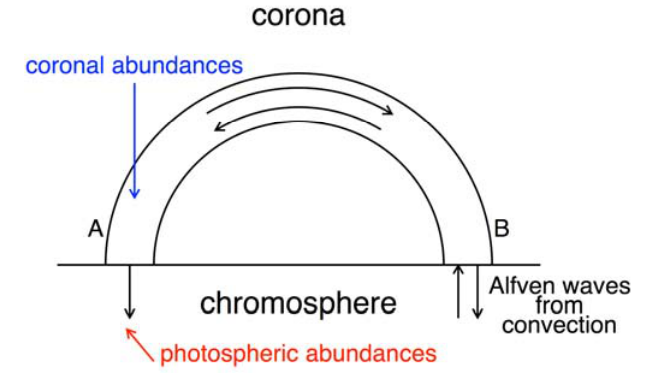
Figure 5. Schematic illustrating the First Ionization Potential (FIP) effect model of Laming (2009) [30]. Alfvén waves are incident on the coronal loop from below on the right hand side. Waves are either transmitted into the loop or reflected back down again.